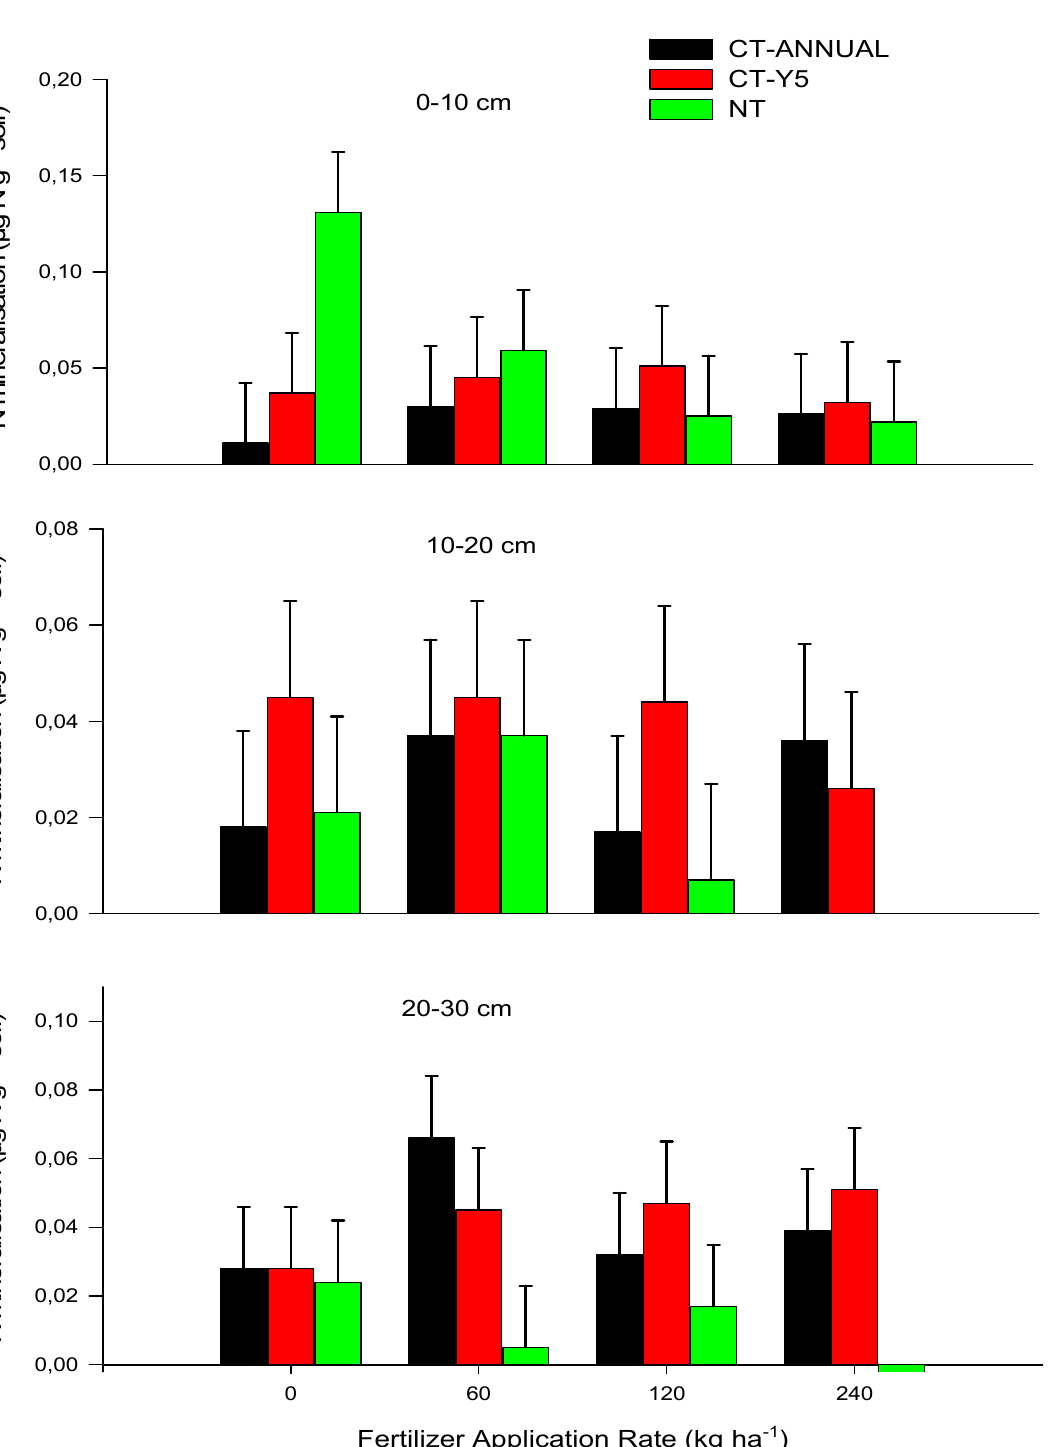
Figure 4. Contents of anaerobic N mineralization according to depth under different tillage techniques and urea fertilizer application rates.